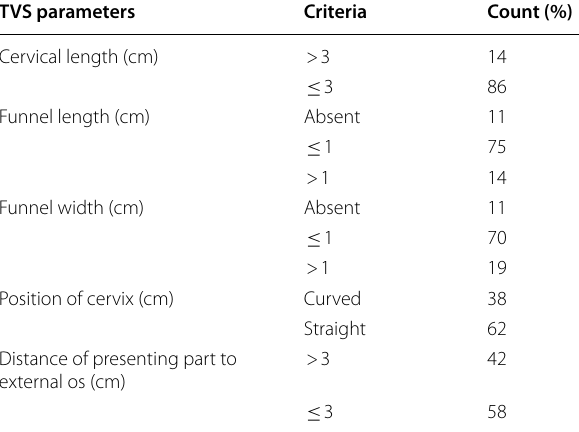
Table 3 Assessment of TVS